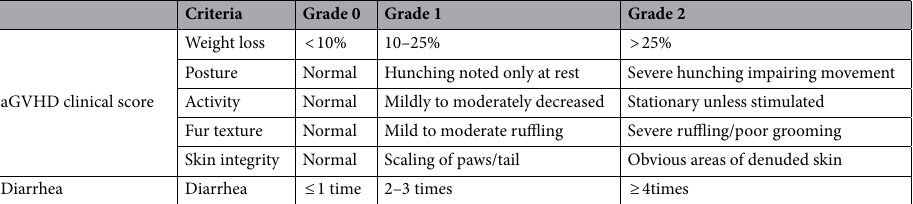
Table 1. aGVHD clinical score and diarrhea score criteria.